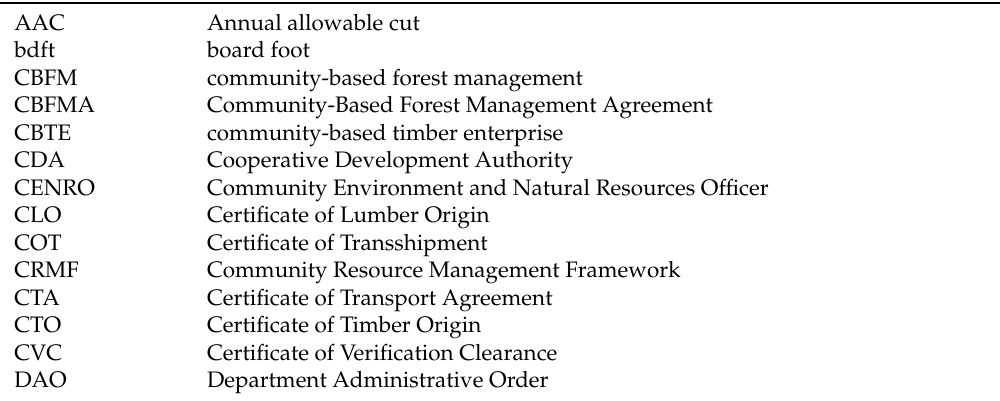
Table 1. List of acronyms used in the